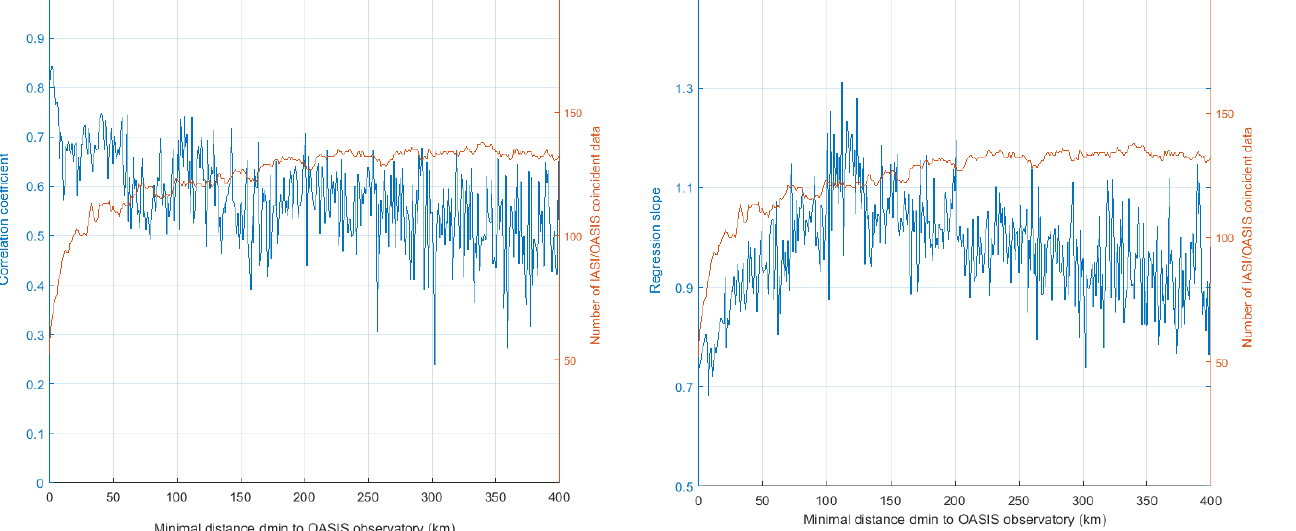
Figure 8. Correlation coefficients R (blue lines, left axis) between IASI and ground-based FTIR observations with temporal sampling difference smaller than 30min, as a function of d min to OASIS ob- servatory, considered for the calculation of the 15km wide rings. The data (orange lines, right axis) show the total number of IASI– OASIS coincident observations.